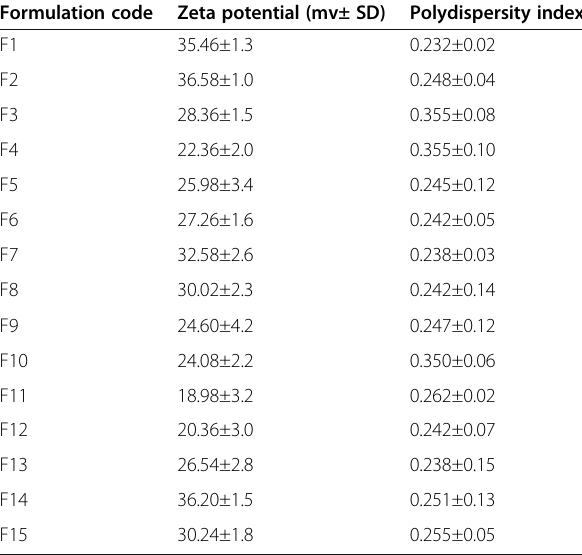
Table 4 Zeta potential and polydispersity index (PDI) of all the formulation